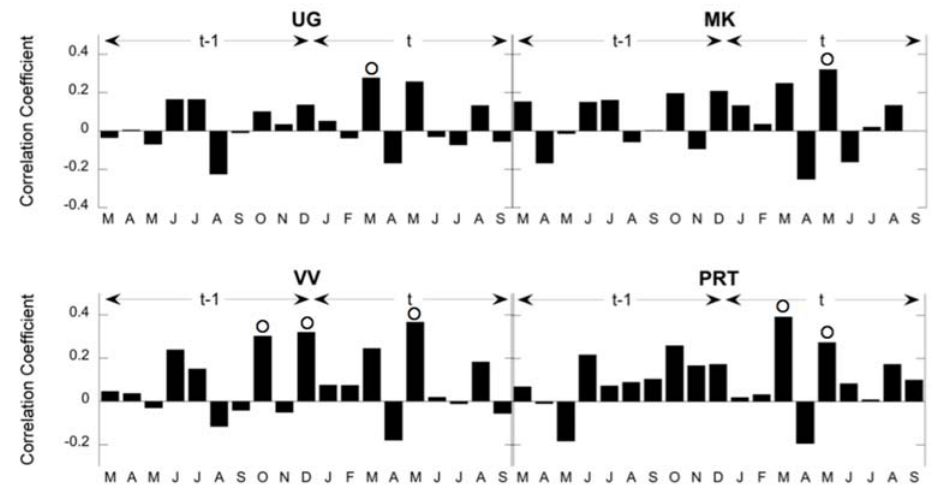
Figure 4. Correlations of the four southern Kamchatka birch ring width chronologies with monthly precipitation from Petropavlovsk-Kamchatsky. The circles denote those months that are significant at the 90% confidence level. In all cases, the period of overlap is 1941–2005 common era (CE).